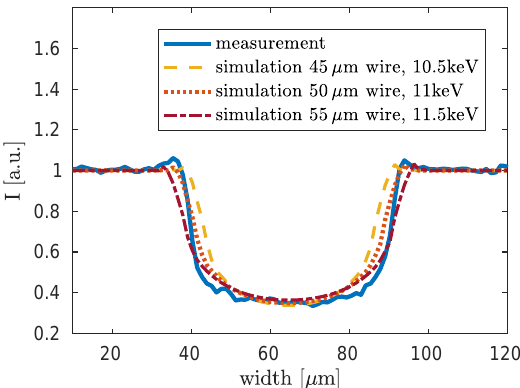
Figure 7. Monochromatic simulation of the propagation signature of titanium wires with varying diameter of ± 10% of the supposed diameter of 50 µ m. The results for the best fitting energies are shown for each diameter. Source-blurring is included in the simulations. A lineplot of the measurement shown in Figure 2 is plotted in blue for comparative reasons. In yellow the simulation of a wire with 45 µ m diameter for 10.5keV, in orange the simulation of a wire with 50 µ m diameter for 11keV and in red the simulation of a wire with 55 µ m diameter for 11.5keV is